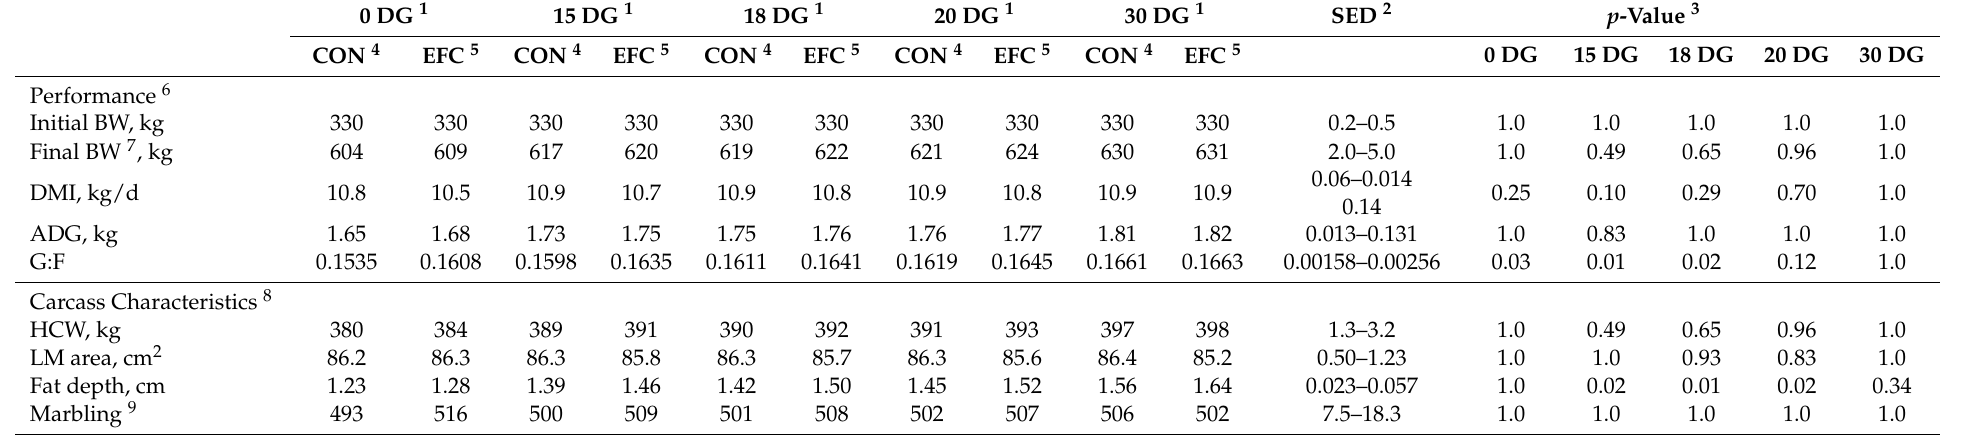
Table 2. Predicted performance outcomes on the effect of the corn hybrids fed as dry-rolled corn in combination with varying inclusion rates of distiller grains on predicted least-square means when finishing cattle performance and carcass characteristics are